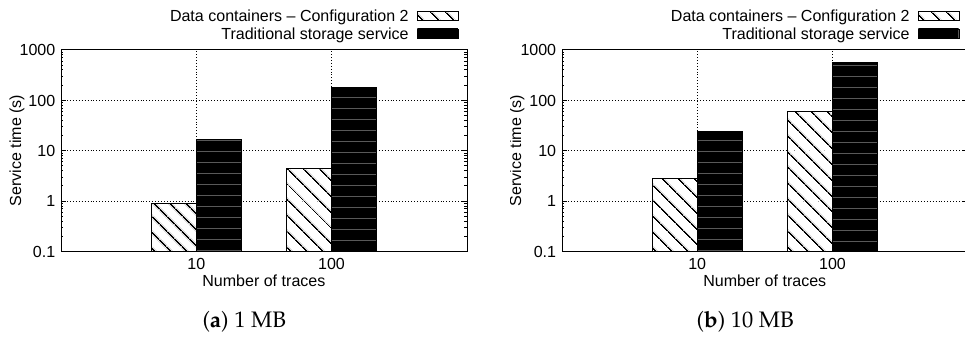
Figure 7. Service time observed when uploading 10 and 100 traces of 1 and 10 MB.